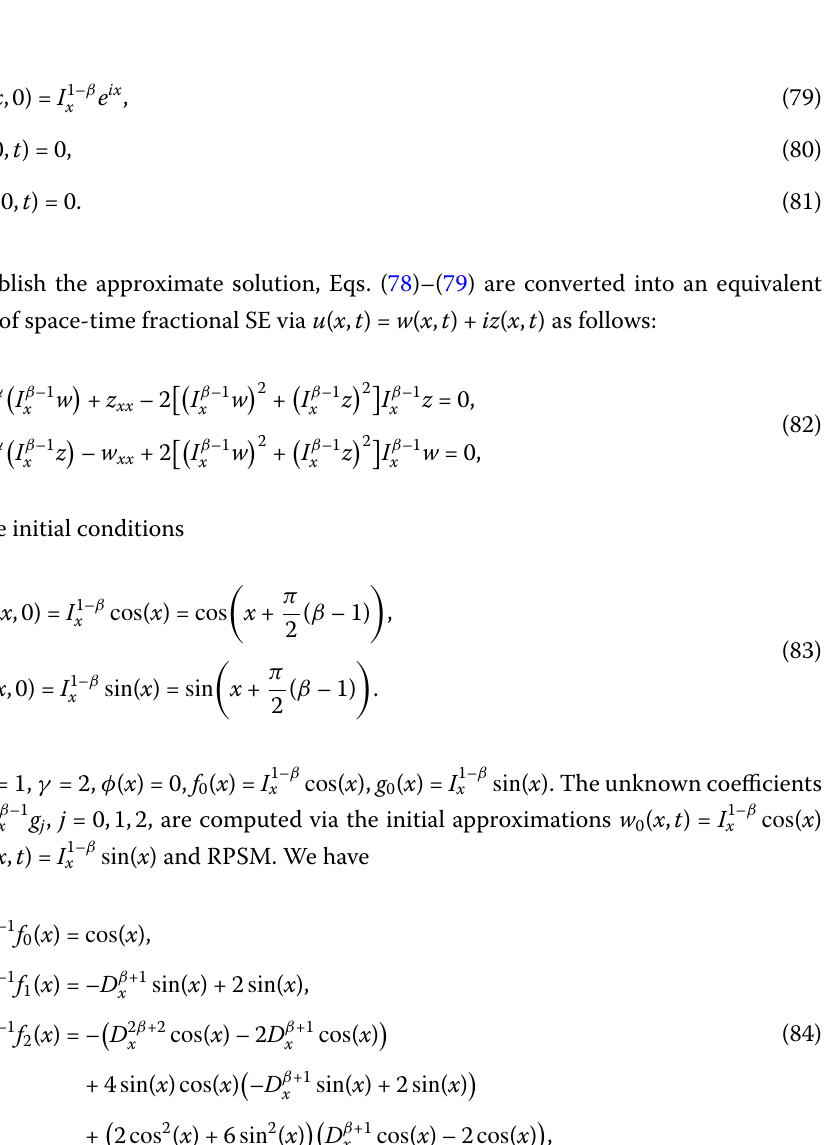
Figure 6 The approximate solution of Example 1 for Case 2 and α = β =